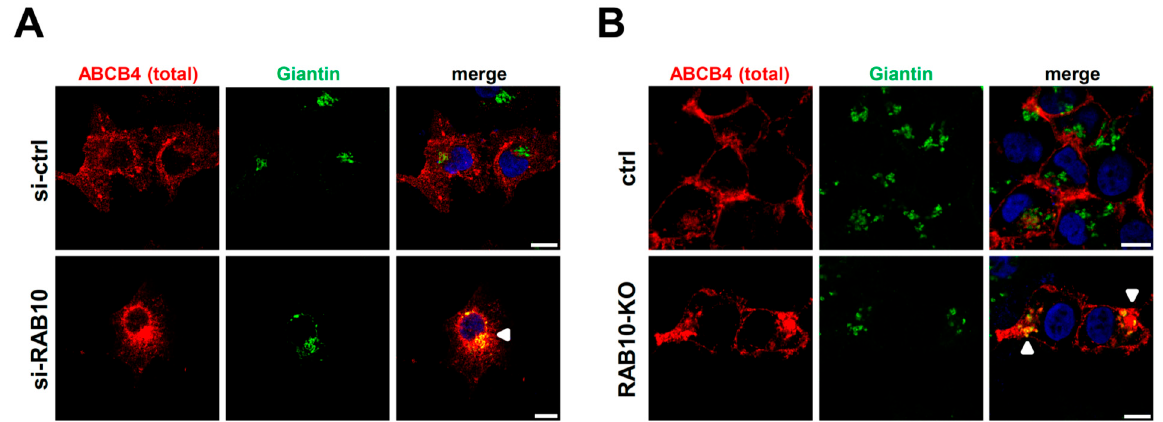
Figure 6. Effect of RAB10 depletion on total ABCB4 subcellular distribution. ( A , B ) HeLa cells transfected with control (si-ctrl) or anti-RAB10 (si-RAB10) (A), and control (ctrl) vs. RAB10-KO HEK cells (B) were used to analyze ABCB4 localization by indirect immunofluorescence and confocal microscopy. ABCB4 (red) and giantin (green) were labeled using specific antibodies while nuclei were stained with Hoechst 33,342 (blue). Each panel is representative of at least three independent experiments per condition. White arrows indicate colocalization of ABCB4 with giantin at the Golgi apparatus. Bars: 10 µm.